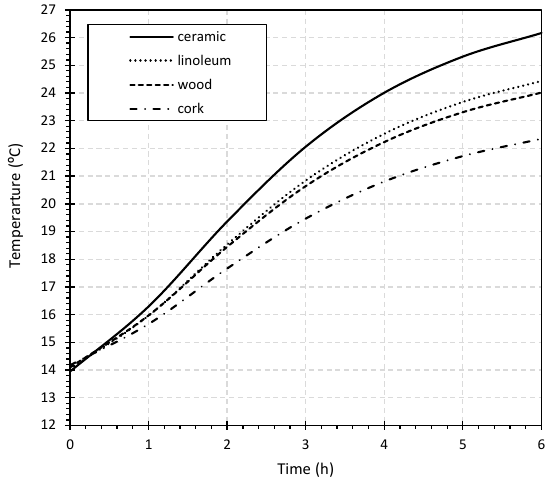
Figure 10. Surface temperature evolution profile for the different finishing materials.